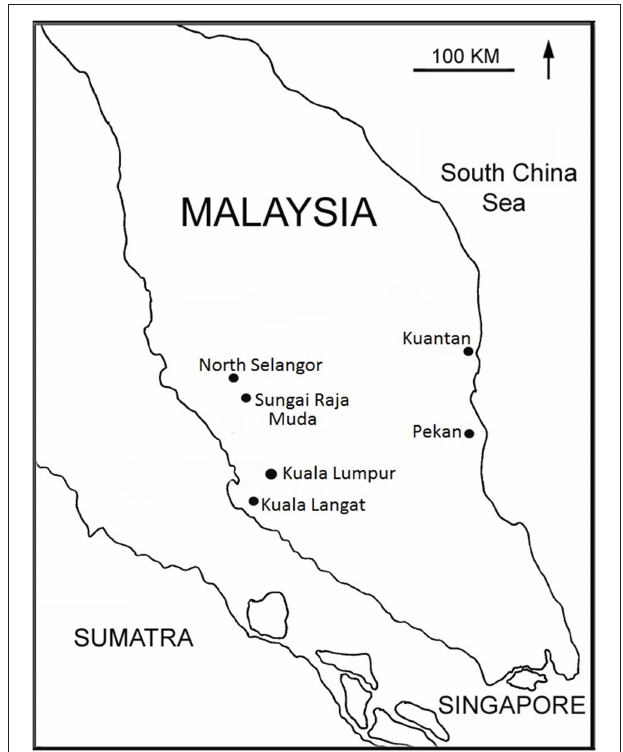
FIGURE 1 | Location of study sites in Peninsular